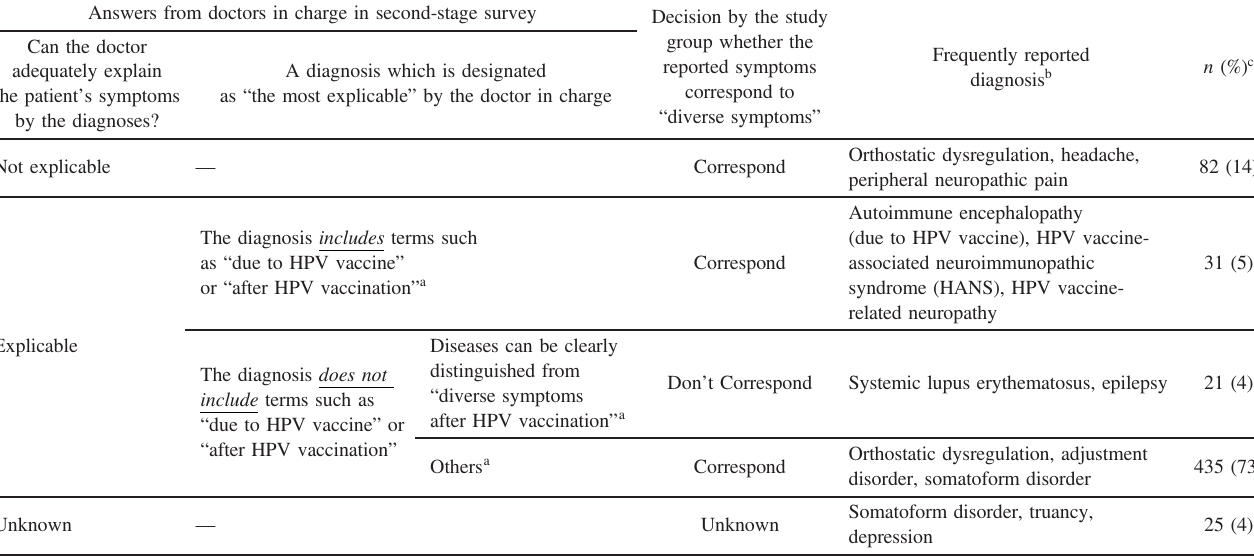
Table 2. Decision process about whether reported symptoms correspond to “ diverse symptoms after HPV vaccination ” Answers from doctors in charge in second-stage survey Decision by the study group whether